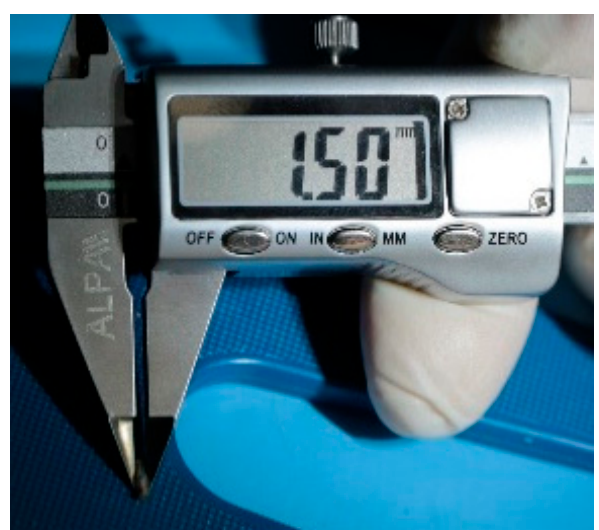
Figure 2. The appearance of the Mg-2Zn-2Ga alloy implants.